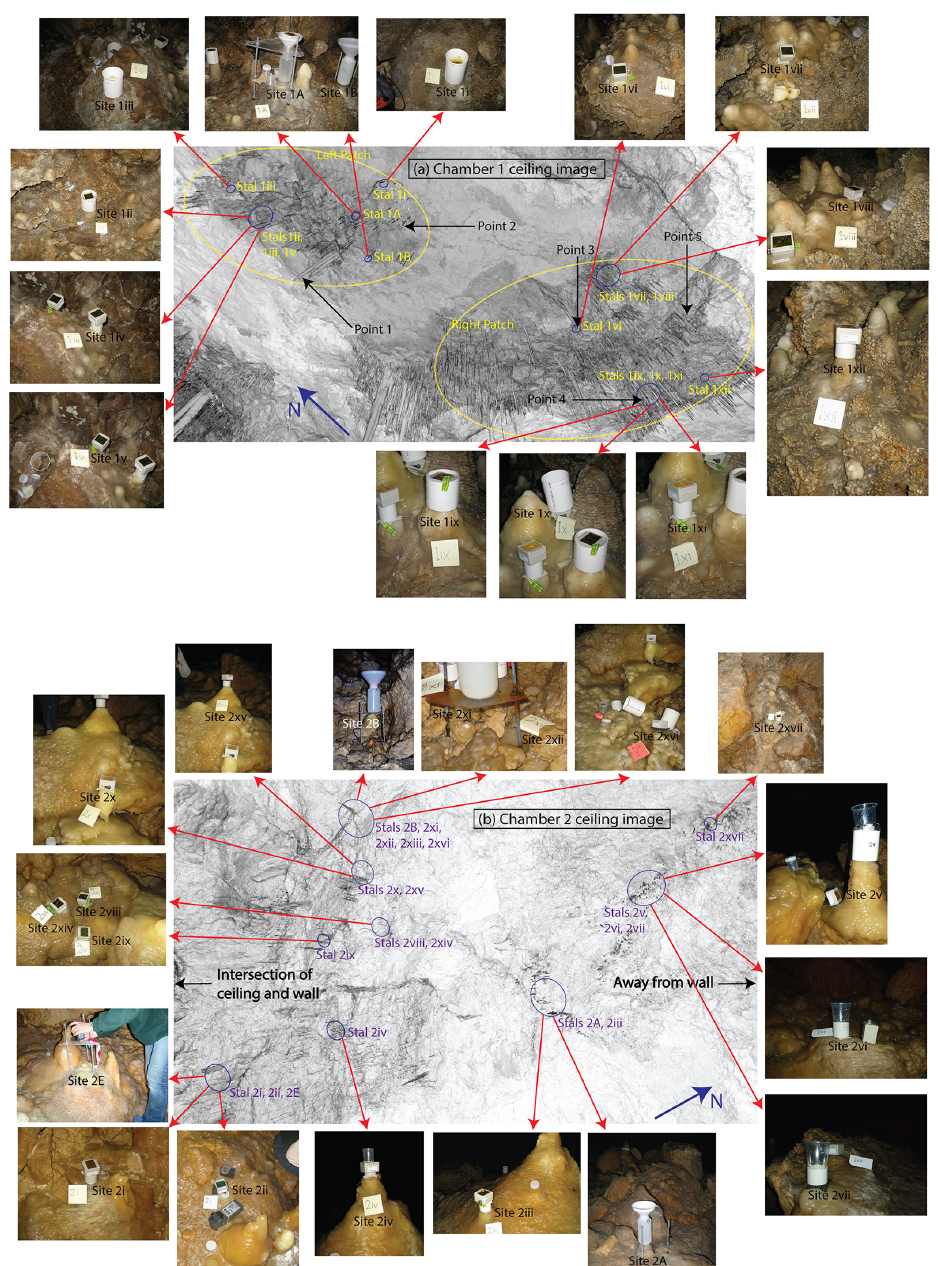
Figure 3. Both monitored ceiling images from T-LiDAR with 34 identified stalactites feeding drip loggers, (a) chamber 1 and (b) chamber 2. Blue circles indicate locations of the ceiling under which the loggers are placed (indicated by red arrows). The blue arrows in both figures show the geographic orientation. These ceiling stalactite locations are identified based on both on-site field observation and the alignment analysis of drip loggers and stalactites (Sect.